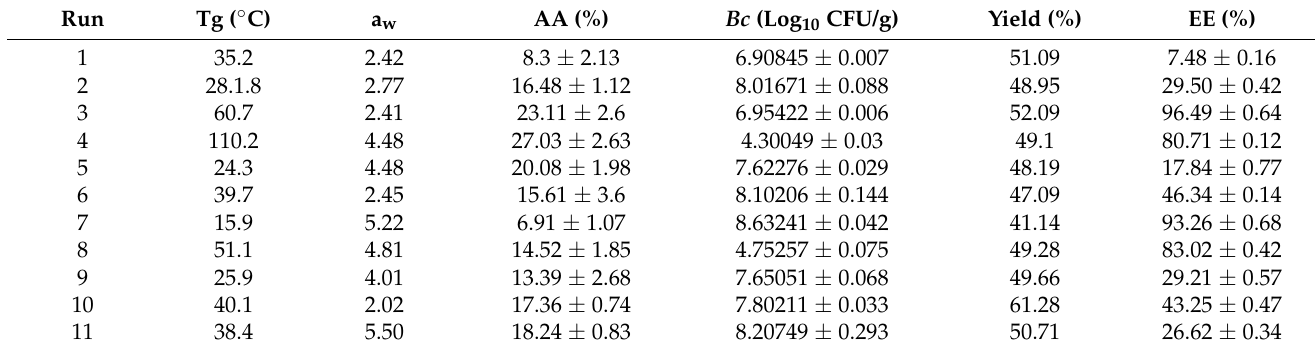
Table 2. Summary of the results of the spray-dried powders containing the active